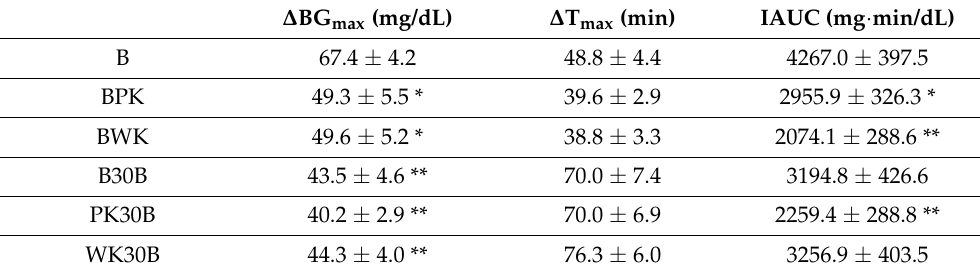
Table 3. Kinetic parameters of ∆ Blood Glucose levels. Values are presented as mean ± SEM ( n = 12).